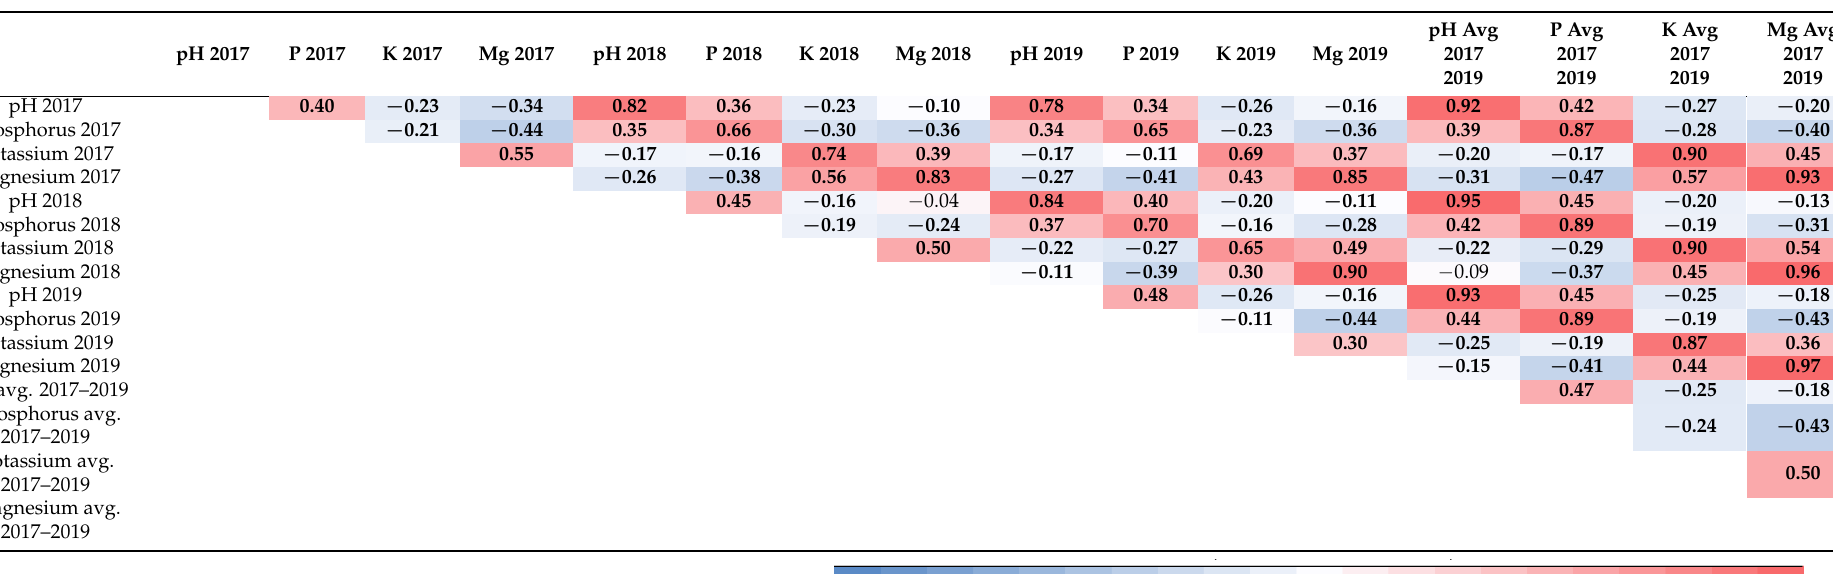
Table 4. Correlation coefficients between pH and content of macronutrients in subsequent years of the study and averages for three years (significant correlations at 0.05 significance level are in bold).